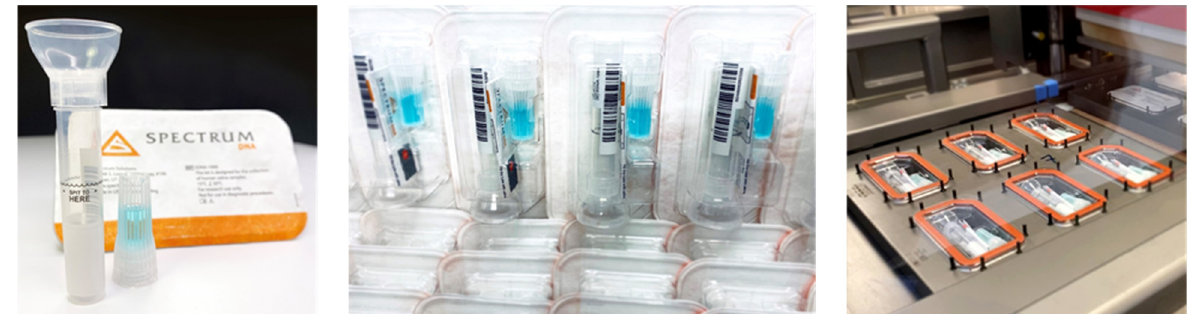
Figure 7. Spectrum Solution’s SDNA collection kit for molecular diagnostics of saliva. The self-collection device is capable of live viral neutralization at room temperature to mitigate risk exposure and sample preservation to identify viral RNA with only 200 copies/mL. Images are reproduced and adapted with permission from Spectrum Solution [27].